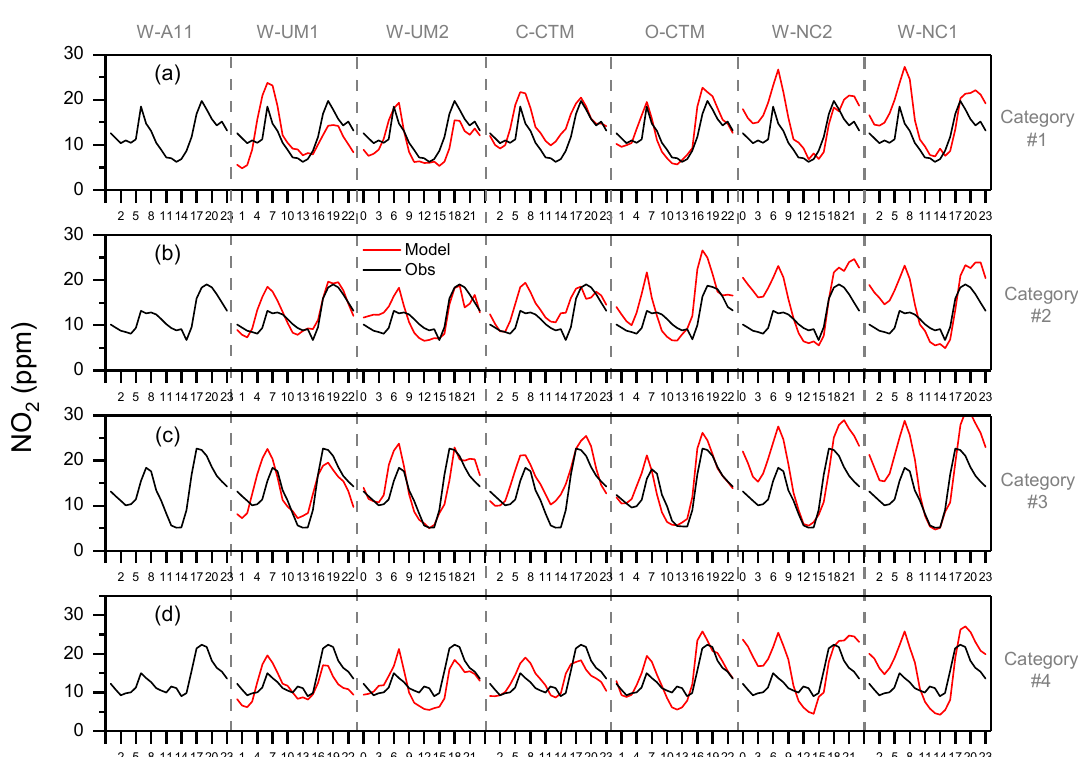
Figure 16. Diurnal composite observed (5 m) and modelled (z 1 average) NO 2 at Westmead. Panels a—d represent each of the four radon-based mixing categories (Table 1).